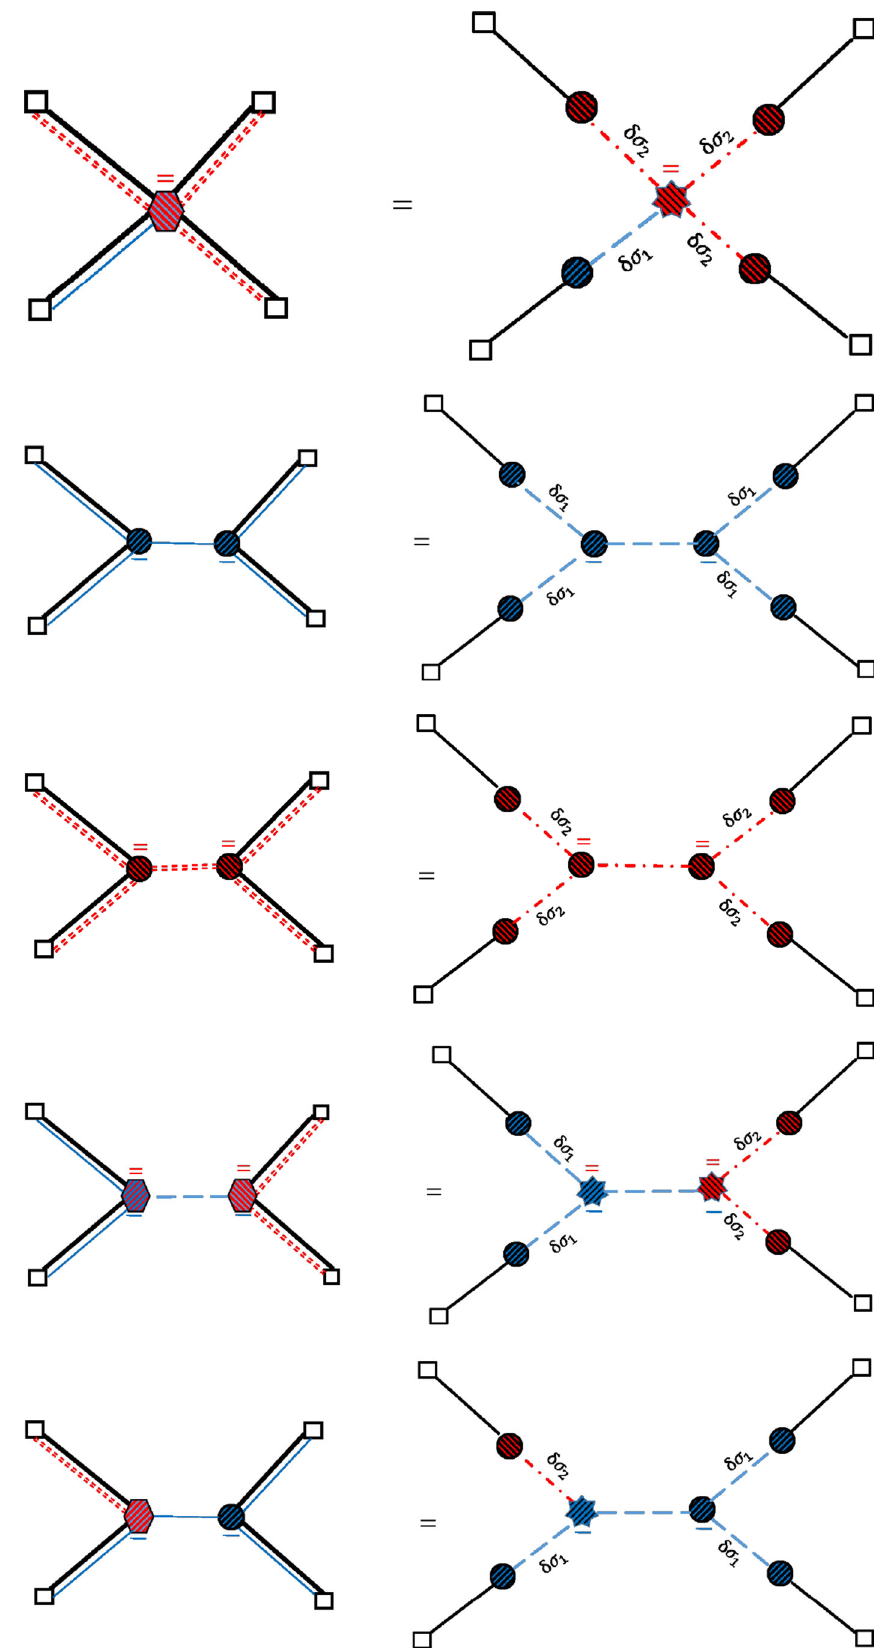
the mixed self interaction for both quasi-massive fields δσ j . The order of interaction originated from terms with